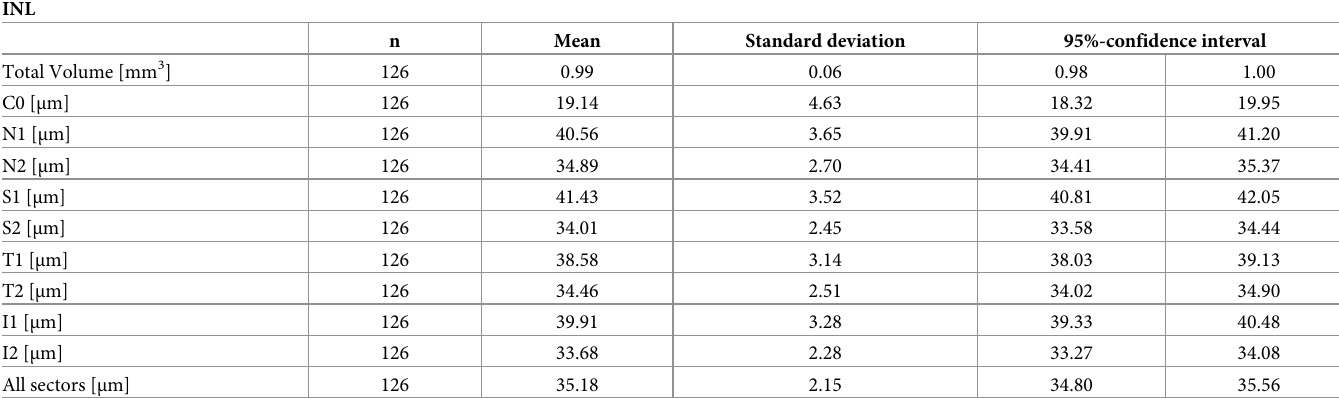
Table 9. INL segmentation.